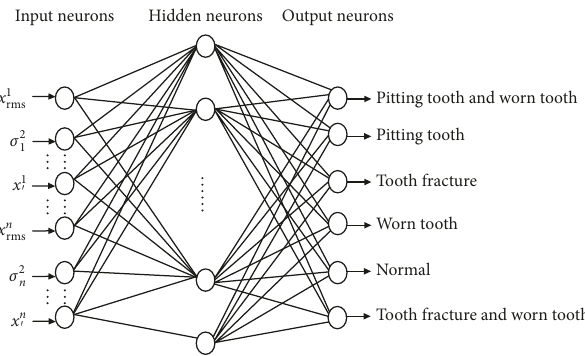
Figure 8: The CBA-KELM-based SLFN fault diagnosis at the same time. Hence, a fused domain matrix with 2369 lines and 66 columns is obtained. The fused time-domain matrix is used to train the KELM model.